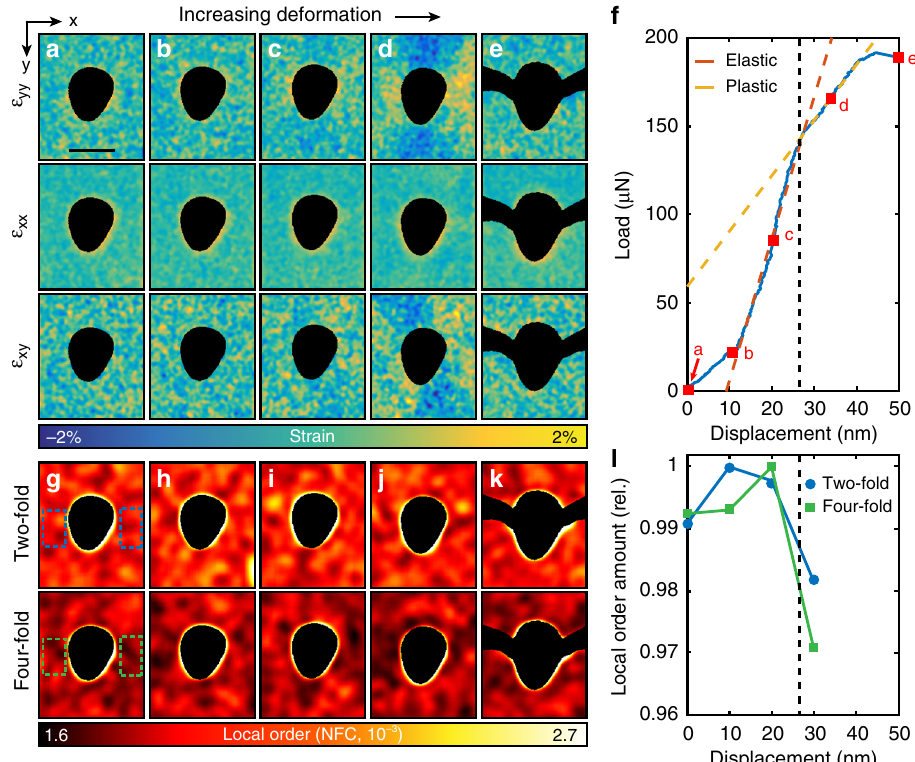
Fig. 2 The results of strain and order mapping during in situ deformation. a – e Strain maps at increasing deformation steps. The scale bar is 150 nm. The top row is strain in the tensile direction, the middle row is strain perpendicular to the tensile direction, and the bottom row of strain maps is shear. By step d plastic strain has developed in the tensile direction. f Load-displacement plot acquired from the in situ TEM mechanical testing holder. The blue solid line is the data acquired, with the displacements corresponding to the different map acquisitions a – e marked with red squares. The orange dashed line is the least squares fi t to the elastic regime, while the yellow dashed line corresponds to the plastic region. The change in slope between c , d is indicative of plastic deformation. The sample fractured before e . The drift in the plot corresponding to the hold times during the NBED acquisitions at the 10, 20, and 30 nm steps has been removed. g – k Maps showing local order at increasing deformation steps as measured from the diffraction patterns. The top row corresponds to two-fold symmetry, while the bottom row corresponds to four-fold symmetry. The scale corresponds to the normalized Fourier coef fi cients (NFC). l A plot showing the relative mean amount of two-fold (blue circle) and four-fold (green square) order in the corresponding areas in g at successive deformations. These areas correspond to 3450 diffraction patterns. The plot shows roughly a 2 – 3% reduction order relative to the maximum over